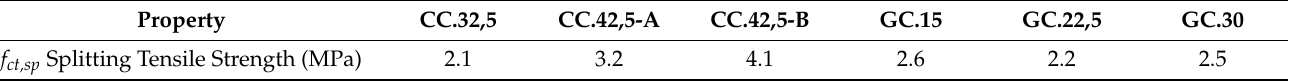
Table 7. Maximum splitting tensile strength.